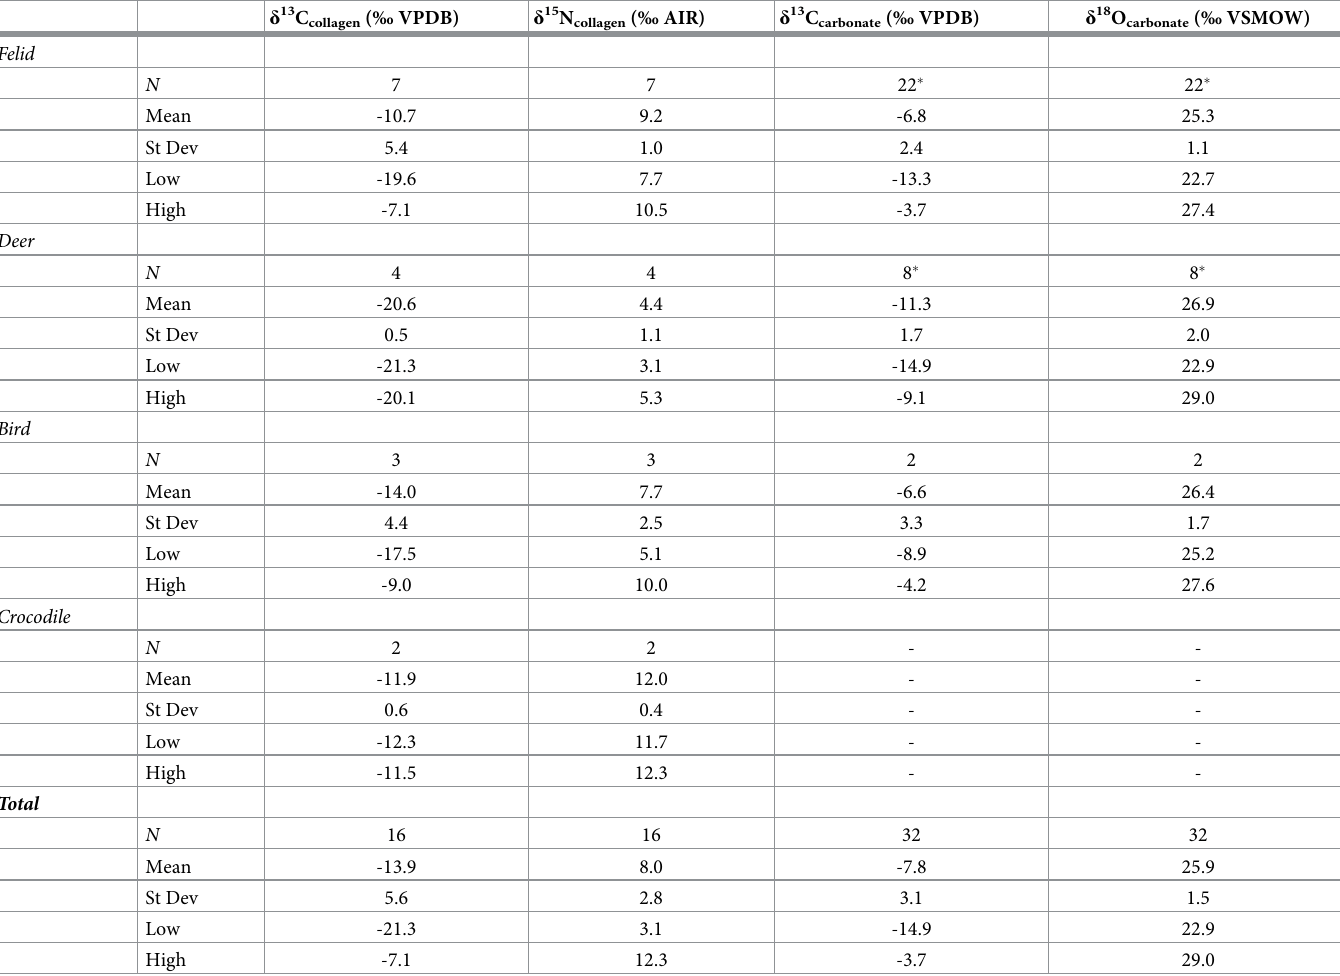
Table 3. Descriptive statistics of the isotope values that passed diagenesis testing by animal